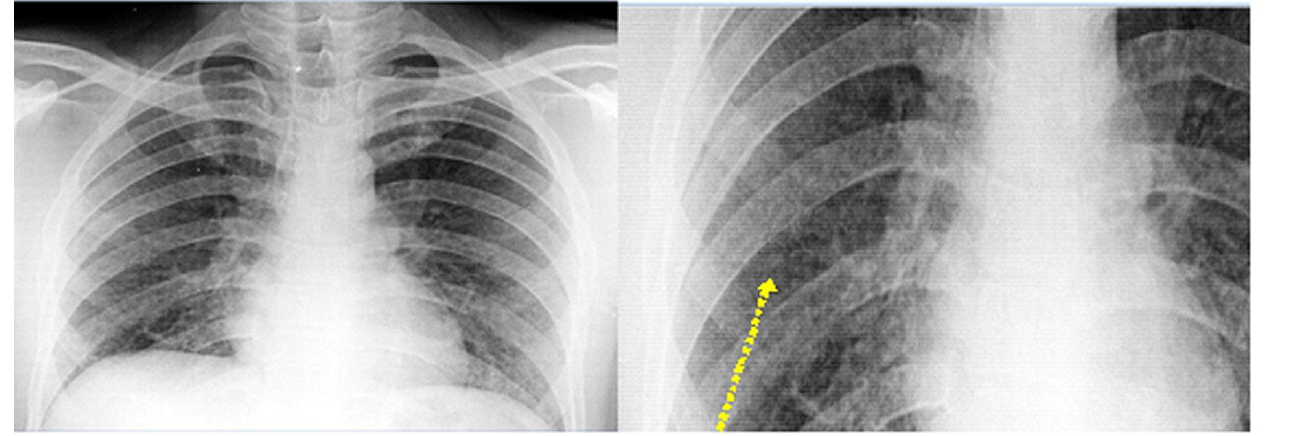
Figure 1: Chest X-ray showing small nodular opacities.